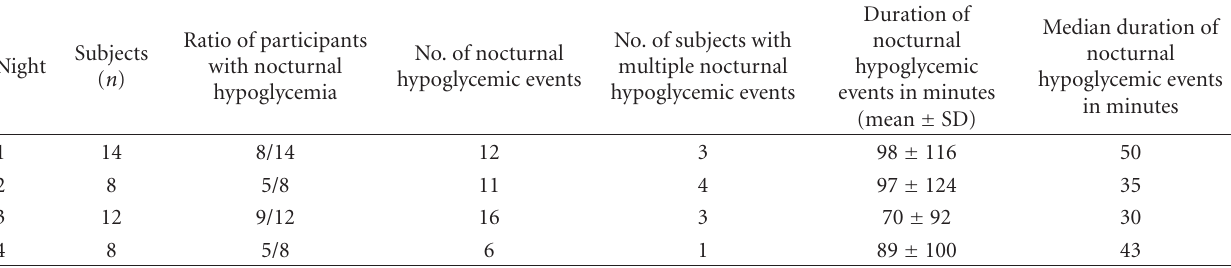
Table 1: Occurrences of nocturnal biochemical hypoglycemia during the evenings of the sports camp.